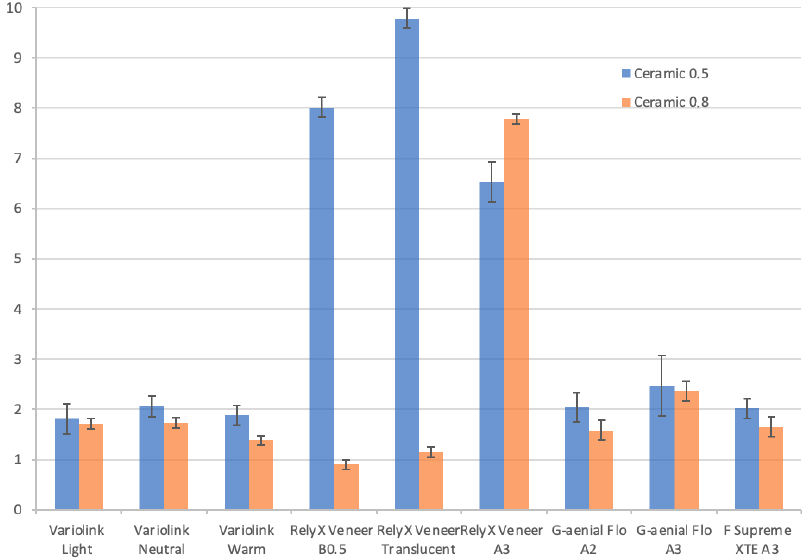
Figure 3. Mean fluorescence values (millions of arbitrary unit, a.u.) and standard deviation bars obtained for bonded ceramic samples according to the resin-based luting agent and the feldspathic ceramic thickness (n = 10).